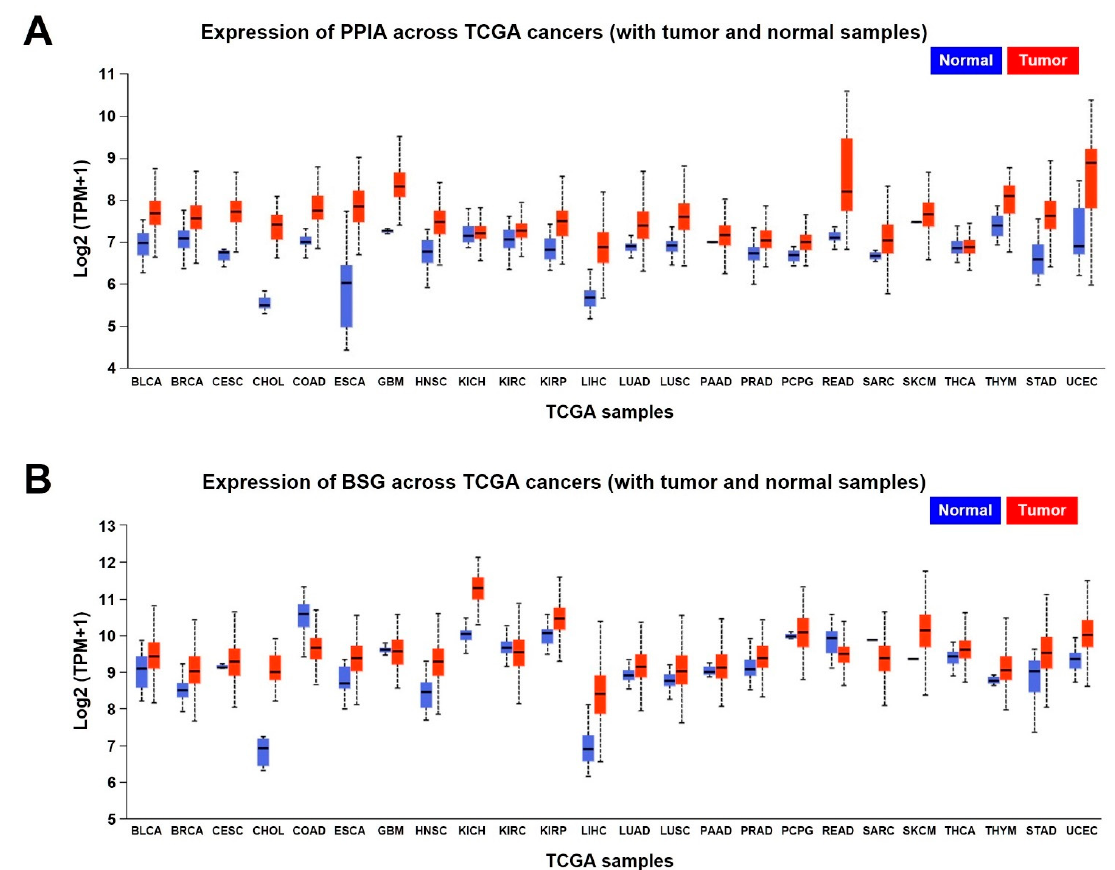
Figure 5. mRNA expression levels of PPIA and BSG in tumor tissues compared with normal tissues. ( A ) Expression levels of PPIA . ( B ) Expression levels of BSG . The data were obtained through